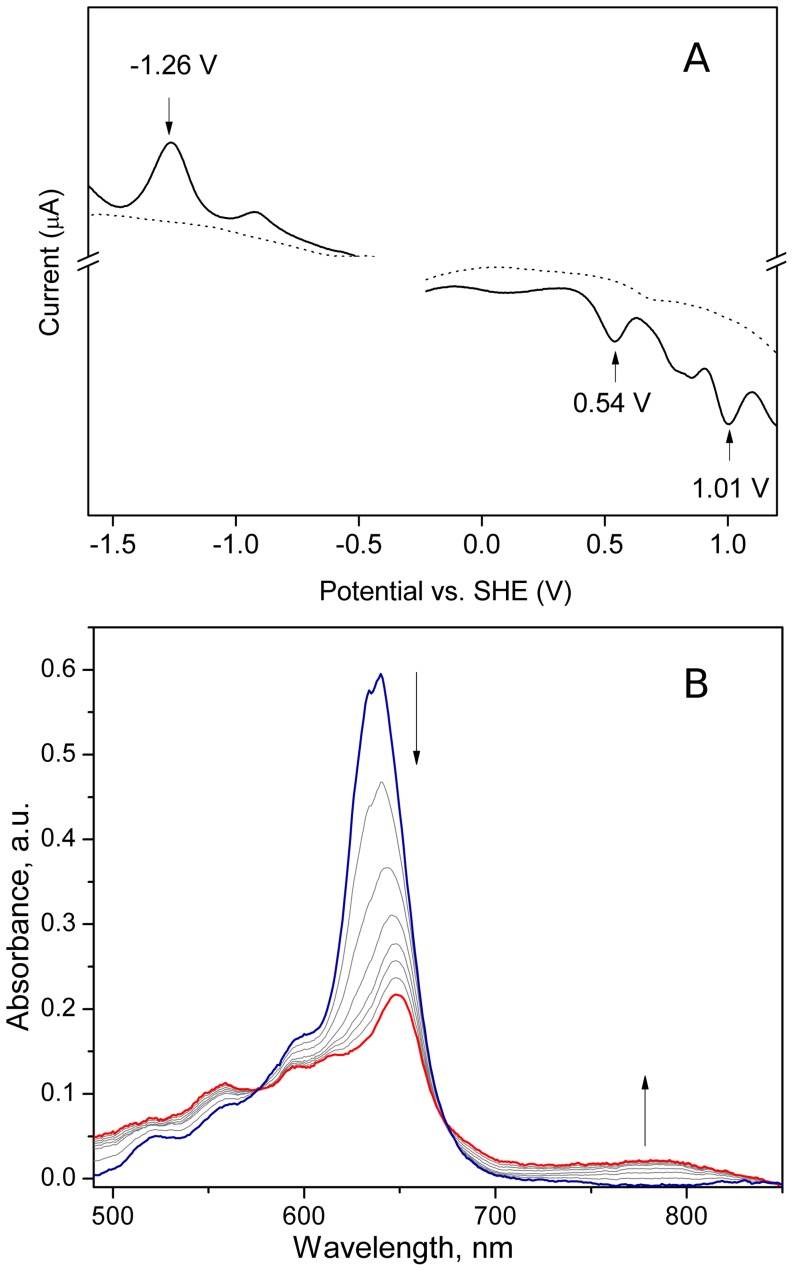
A: Differential pulse voltammogram of ZnCe6 in DMSO with 0.1 M TBAPF6. [ZnCe6] = 1 mM. Voltammogram of the solvent is shown by dotted line. B: Spectral changes during the oxidation of ZnCe6 at 0.54 V. See Results for details.